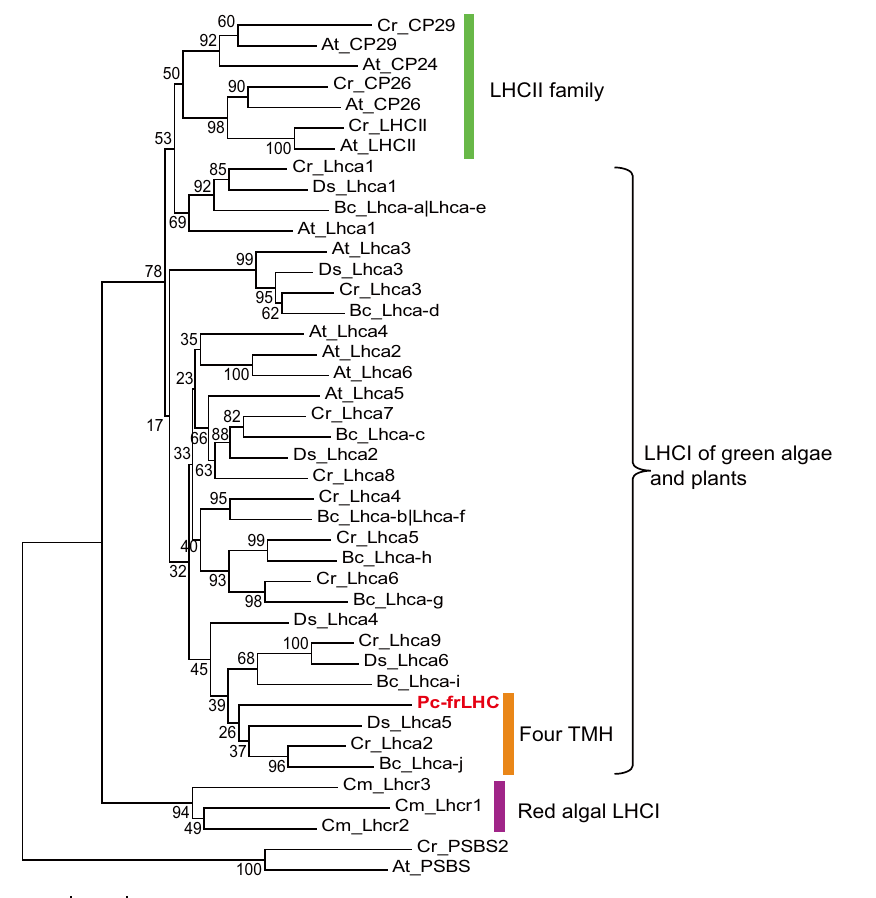
Fig.3|Phylogenetictreeoflight-harvestingcomplexes(LHCs)ofPSIandPSIIin green algae and plants. Evolutionary analyses of LHCs were conducted with the neighbor-joiningmethodinMEGA7 50 .Weusedaminoacidsequencesofonlythose LHCs inwhich 3Dstructural analyseshadbeen achieved.The optimaltree with the sumofbranchlengths=17.75479796isshown.Thepercentageofreplicatetreesin whichtheassociatedtaxaclusteredtogetherinthebootstraptest(1000replicates) is shown next to the branches. The evolutionary distances were computed using thePoissoncorrectionmethod.Theratevariationamongsiteswasmodeledwitha gamma distribution (shape parameter = 3). While most LHC subunits have only three transmembrane helices (TMH), a few LHC subunits, such as Cr_Lhca2, Bc_LhcaJ (Bc_Lhca-j in the fi gure), and Ds_Lhca5, have been known to possess a fourth transmembrane helix. Abbreviations: Cm: Cyanidioschyzon merolae (red alga);Cr: Chlamydomonasreinhardtii ;Bc: Bryopsiscorticulans ;Ds: Dunaliellasalina ;